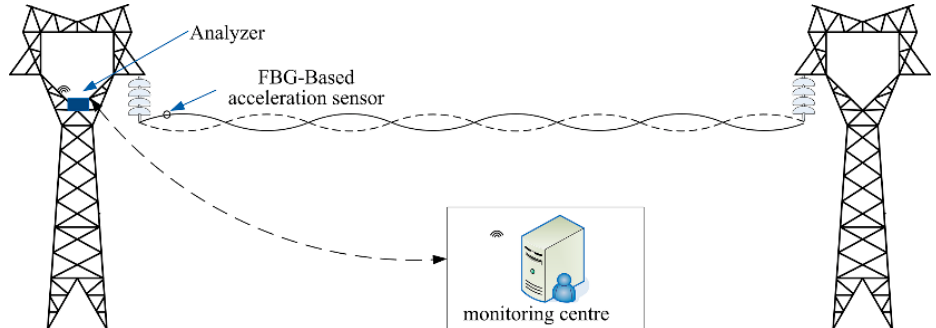
Figure 8. Overall diagram of the monitoring system. FBG = fiber Bragg grating.